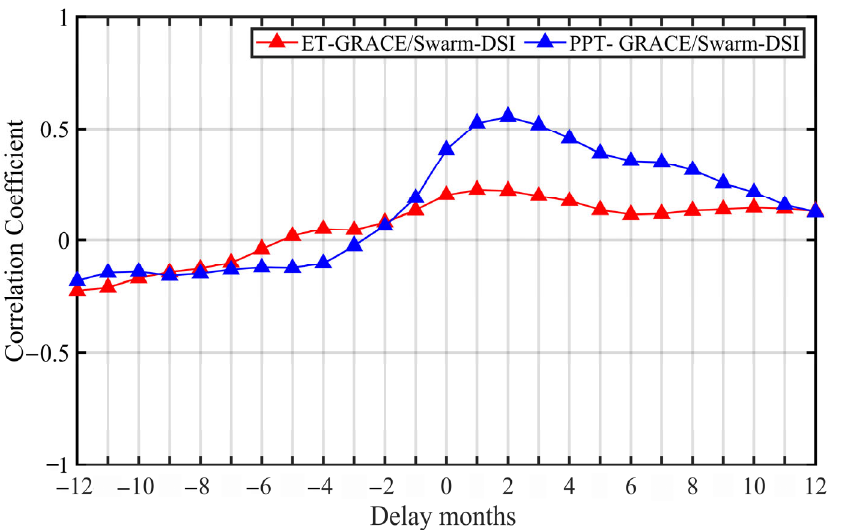
Figure 12. The correlation coefficients and delay months between GRACE/Swarm ‐ DSI and PPT anomaly, ET anomaly in the ARB (The correlation coefficient results have passed the 95% confidence level).